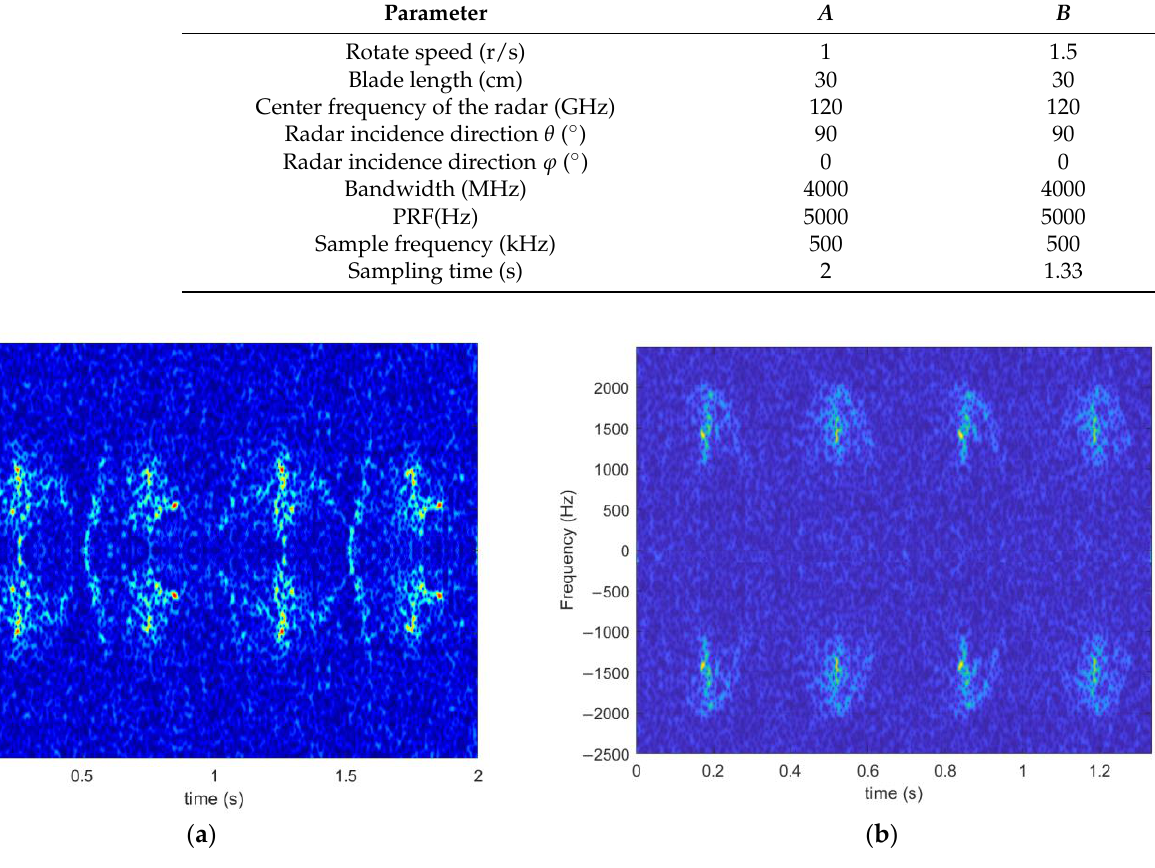
Figure 10. Experimental results of different rotational speeds of the two-bladed helicopter rotor: ( a ) Time – frequency distribution of P1. ( b ) Time – frequency distribution of P2.